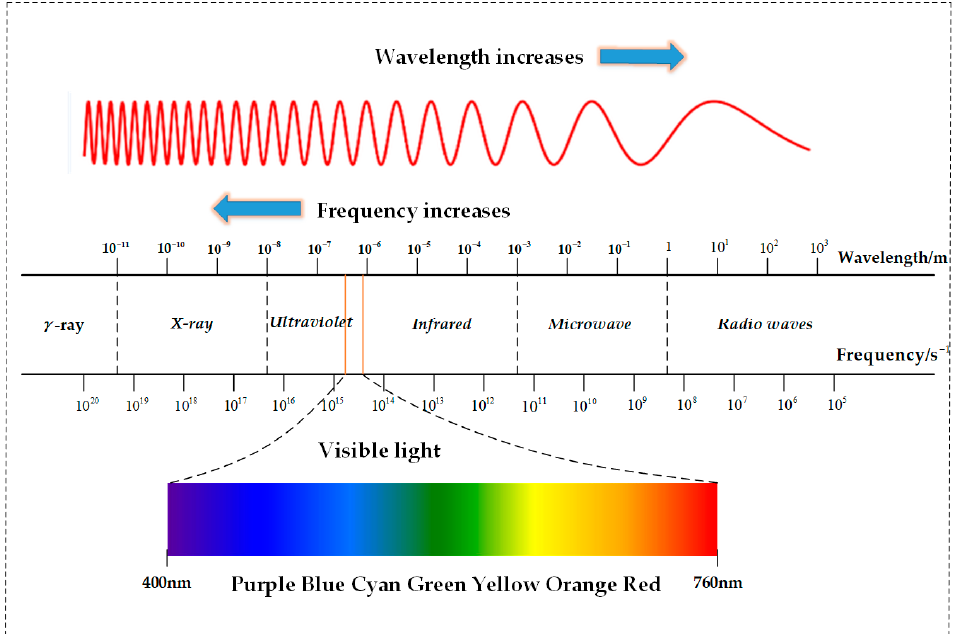
Figure 2. The electromagnetic spectrum.